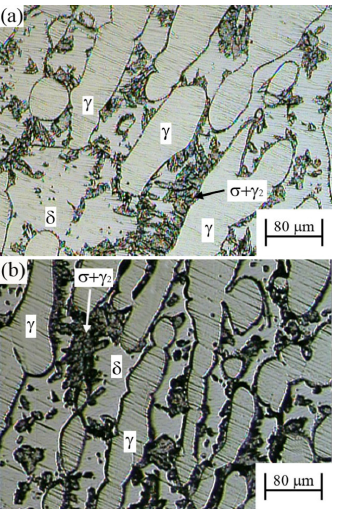
Figure 10. Microstructures observed after DL-EPR tests in SD-B aged at 850 °C for 45 min.